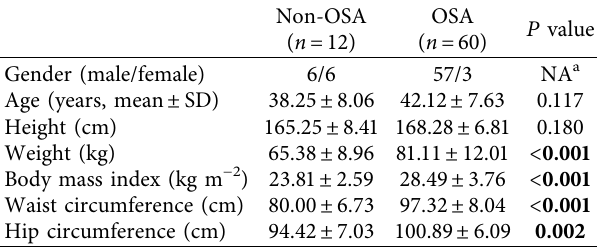
Table 1: Participant